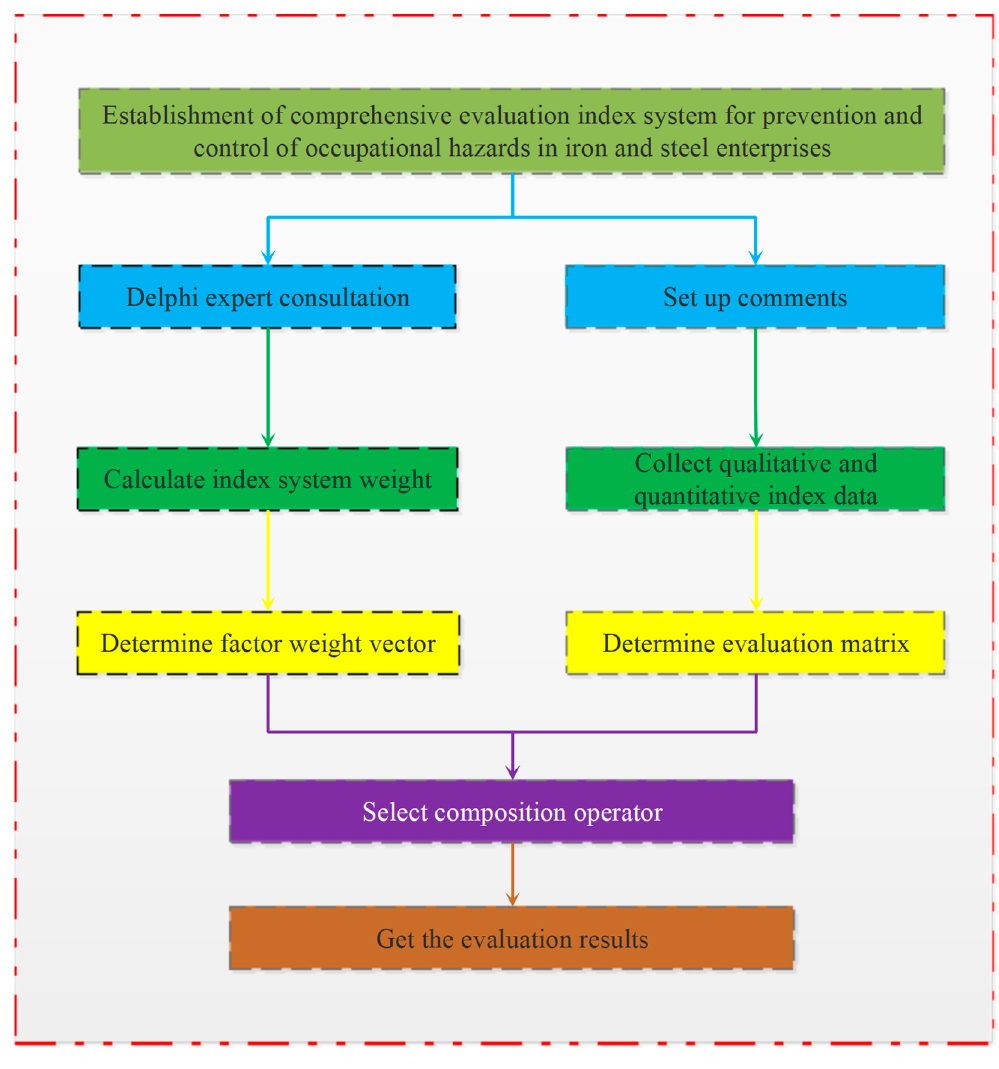
Figure 1. Flow chart of evaluation system.